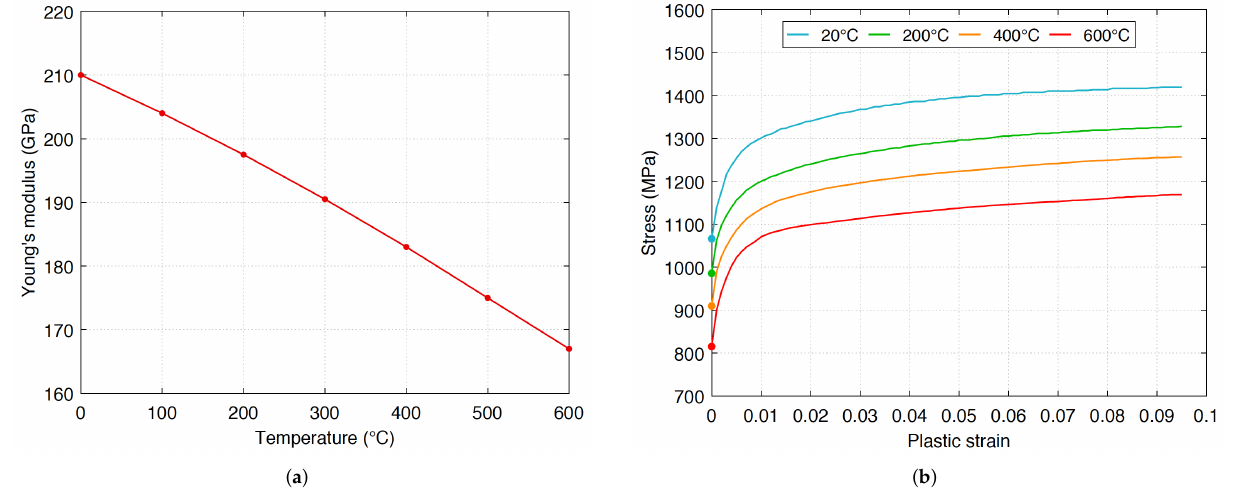
Figure 7. Elasto-plastic properties of the Inconel 718 superalloy: ( a ) Young’s modulus [22]; and ( b ) plastic strain–stress curves